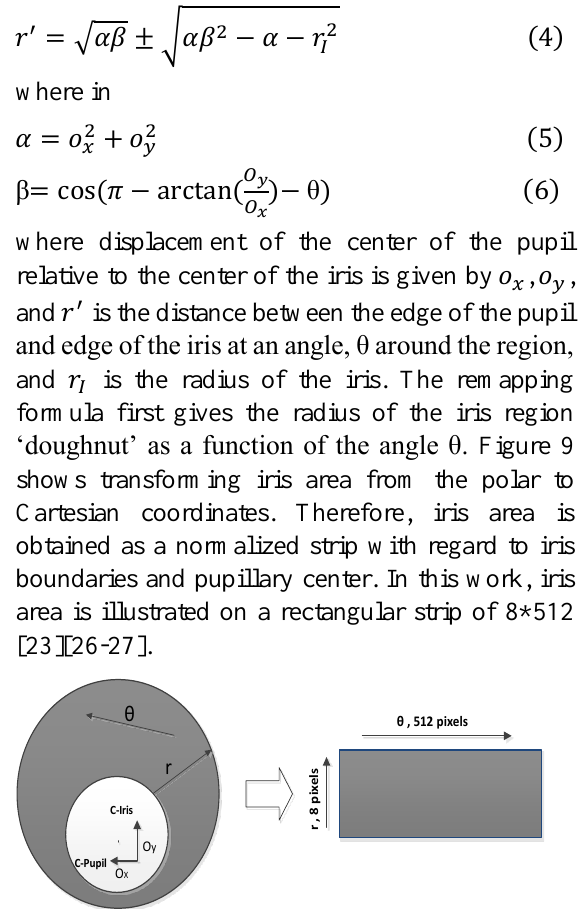
Figure 9. Transforming polar to Cartesian coordinates.